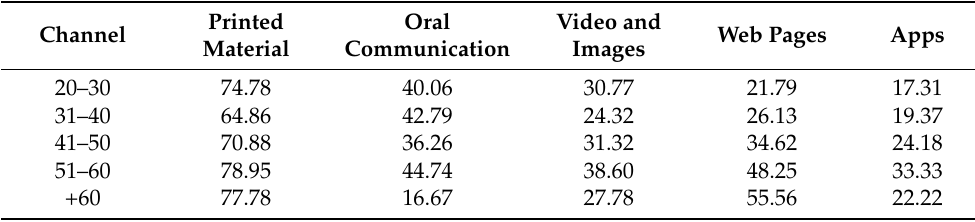
Table 4. Percentage of communication channels for different age